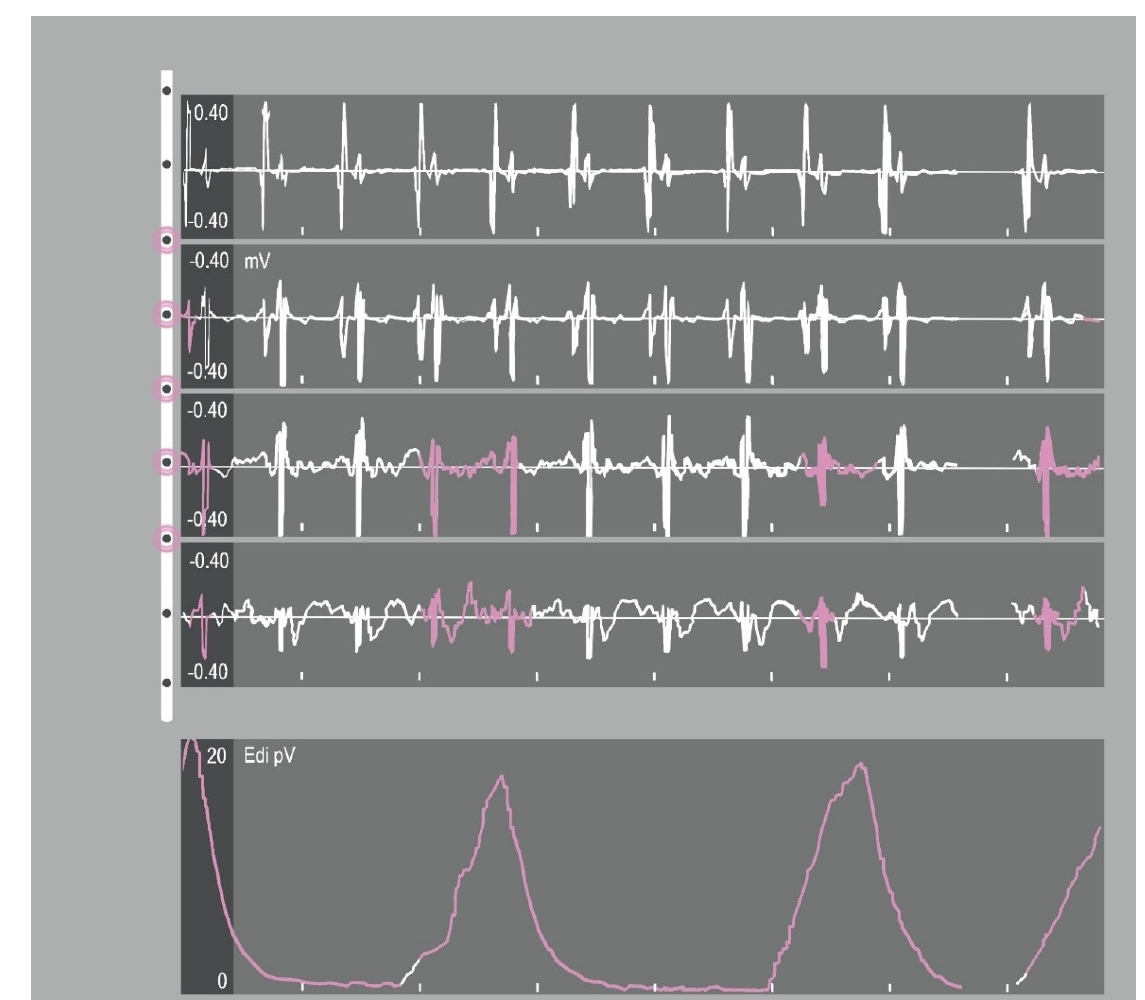
Figure 2. Catheter-positioning tool screen. The tool shows the progression of the retrocardiac electro- cardiogram (ECG) complexes. The electrical activity of the diaphragm (Edi) signal (bottom tracing) is superimposed over the EKG tracings and should be in the middle tracings for optimal placement. Brender implemented the information derived from transoesophageal electrocardio- gram interpretation, considering the relative position of right atrium and diaphragm